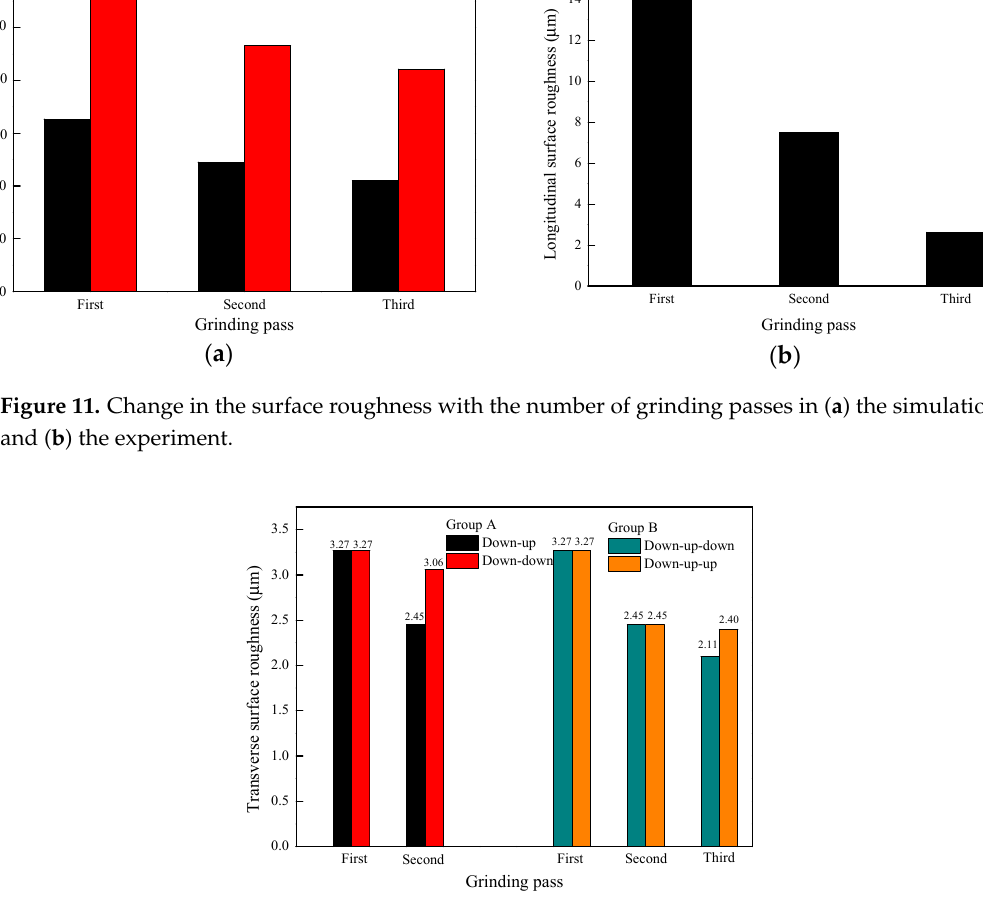
Figure 12. Change in the surface roughness with a change in the grinding direction.